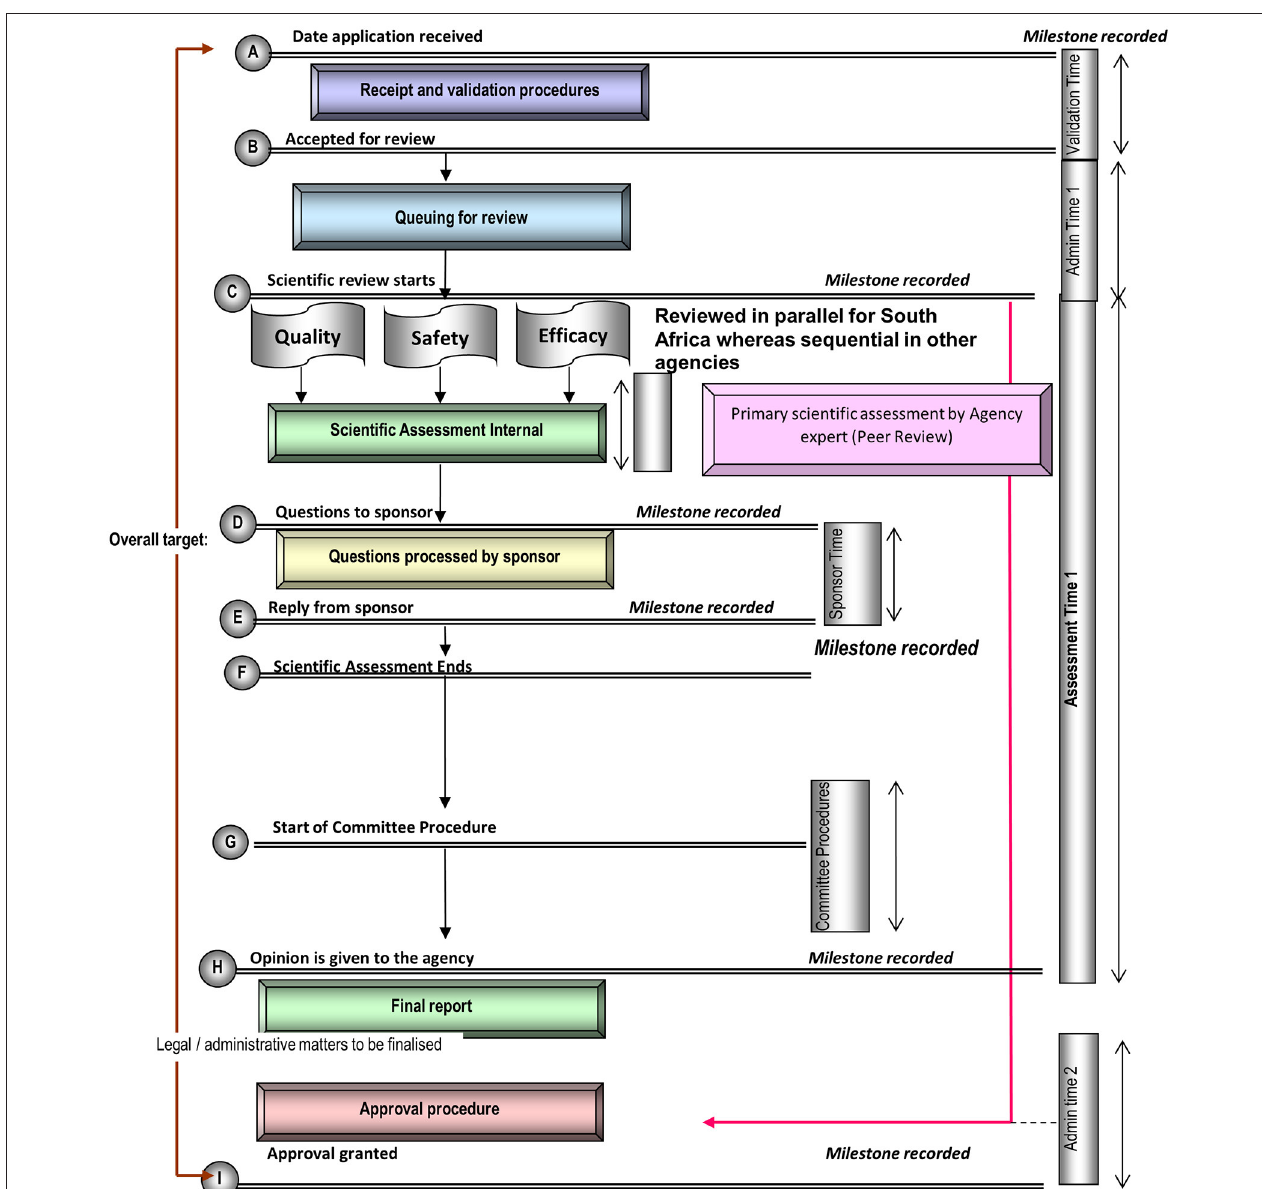
FIGURE 3 | Standardized review process map for regulatory agencies. The map represents the review and authorization of a product that goes to approval after one review cycle. It should be noted that in some countries milestone G (committee procedure) may come before milestone D (questions to the